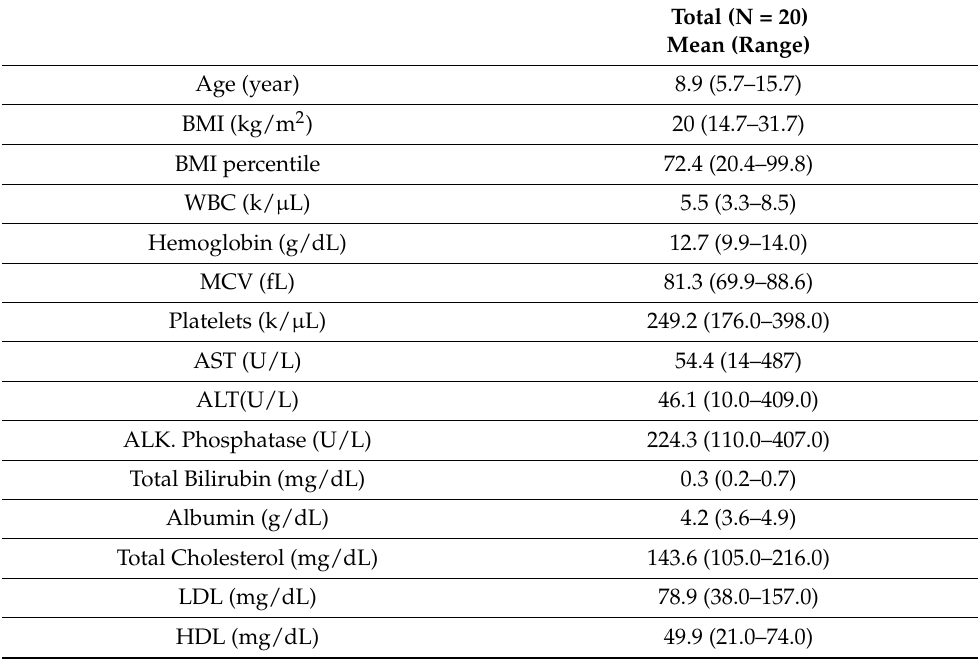
Table 2. Patient demographic and laboratory